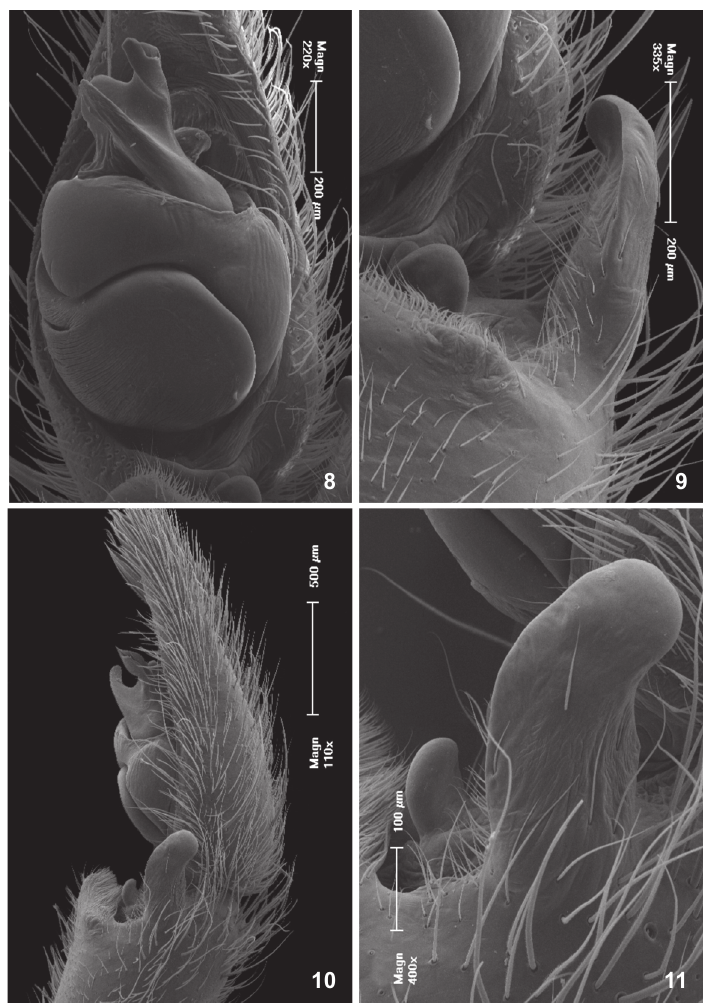
Figures 8-11. Syntrechalea robusta sp. nov. , male palpus: (8) detail of bulbus, ventral view; (9) detail of retrolateral tibial apophysis, ventral view; (10) male palpus, lateral view; (11) detail of ectal division of retrolateral tibial apophysis, lateral